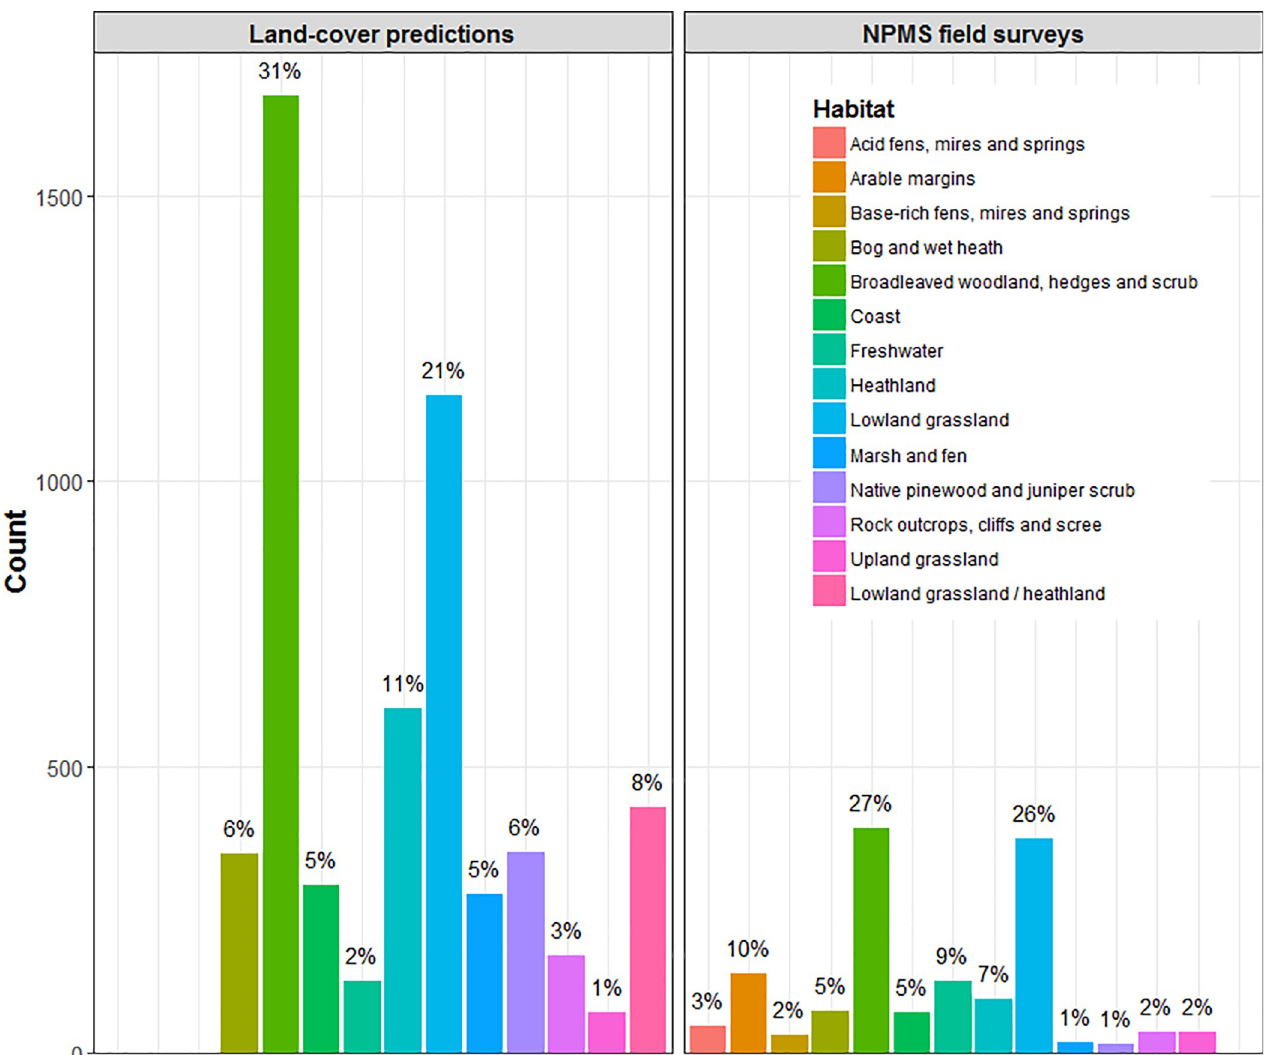
Fig 5. Land cover inventory information per monad compared to NPMS surveyor returns. The occurrence of NPMS broad habitat types across the monads released for survey (2015–16; n = 2687). Frequencies of land cover types from existing inventories are compared with the frequency with which broad habitats were found at least once within a monad by volunteers (percentages are also given for easier comparison of the relative composition of the two information types). Land cover data comes from the LCM 2007, the Natural England Priority Habitats Inventory, and the Welsh Phase One map, with categories matched to NPMS broad